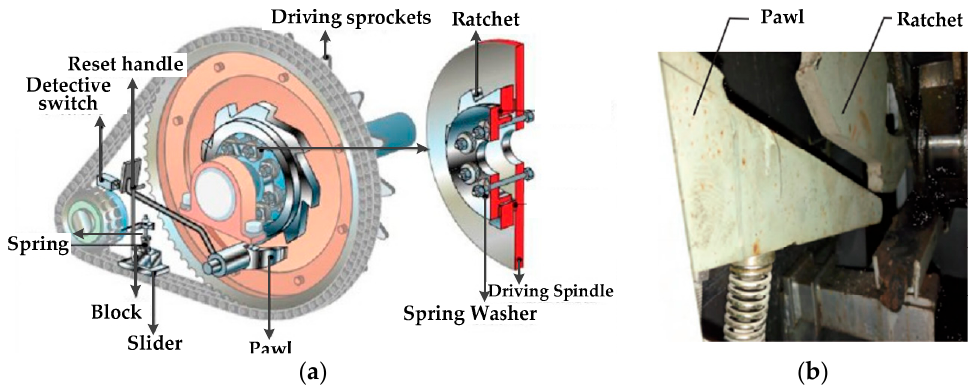
Figure 7. Mechanical structure of escalator emergency brake: ( a ) Mechanical structure diagram of escalator emergency braking systems (EEBS), ( b ) Actual ratchet structure.